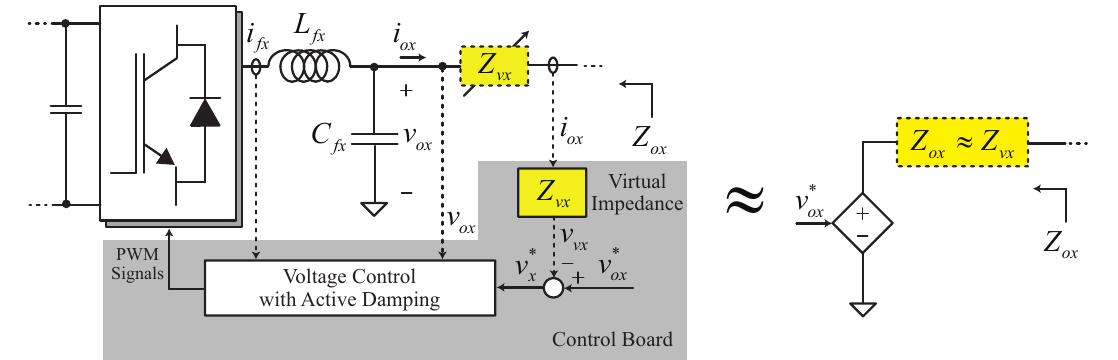
Figure 3. Equivalent circuit diagram of inverter-based